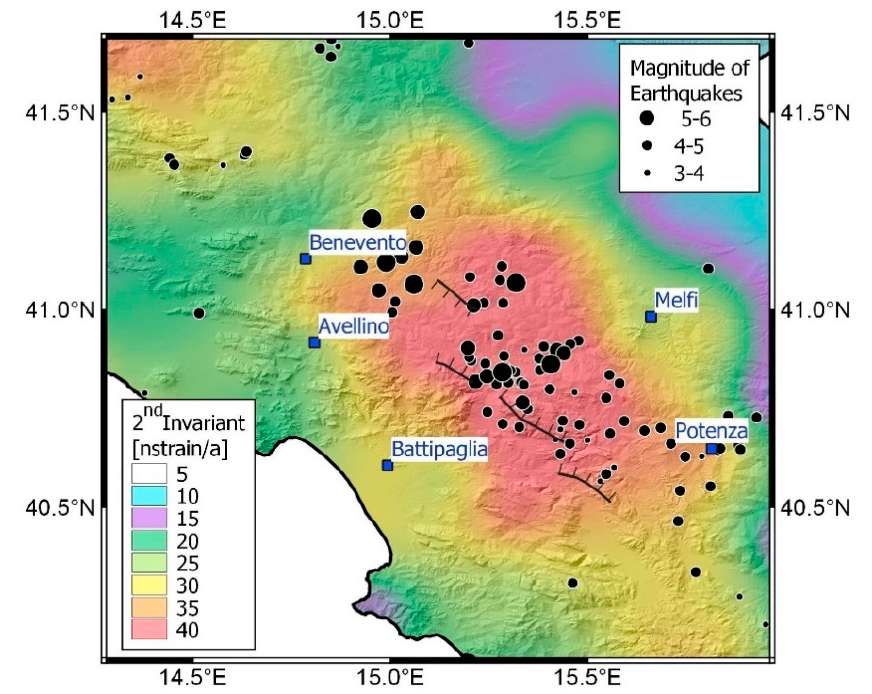
Figure 5. Map of the horizontal strain rate field of Irpinia derived from GNSS and InSAR during more than two decades of observation (1990–2017). The main earthquakes that occurred from 1466 to 2017 are represented on the map. The main towns of the area are drawn and labeled with dark blue squares, and the main faults (see Figure 2 (top)) are represented with black hashed lines. Since the strongest shallow events that occurred inland in Italy from 1990 to today are placed only in areas characterized by high strain rates [17], the high strain rate detected in Irpinia implies—from a theoretical point of view—a scenario where a new strong earthquake seems more likely. This can be somehow counterintuitive, because this area hosted most of the strongest earthquakes in southern Italy after 1908, in 1930, 1962, and 1980: only the Mw 6.4 1968 Belice and the Mw 6.0 1978 Patti gulf events (both in Sicily) reached similar magnitudes [26]. Only in the NE Sicily 1978 earthquake was the strain rate as high as in Irpinia. Therefore, from this point of view, we can hypothesize that in Irpinia, the probability of a new strong event is still very